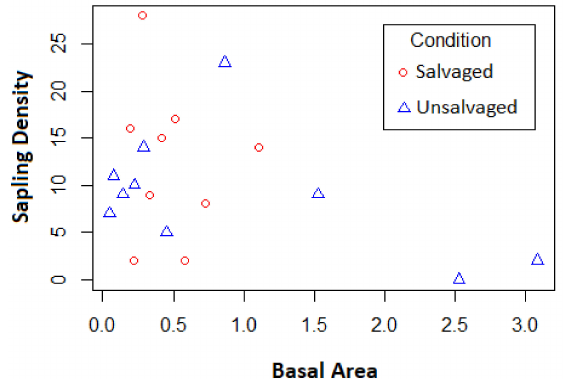
Figure 4. Scatterplot of plot (400 m 2 ) surviving tree basal areas vs sapling density in 2017 by condition. Salvaged plots had a Pearson’s correlation of − 0.11 ( p = 0.78). Unsalvaged plots had a Pearson’s correlation of − 0.51 ( p = 0.14).